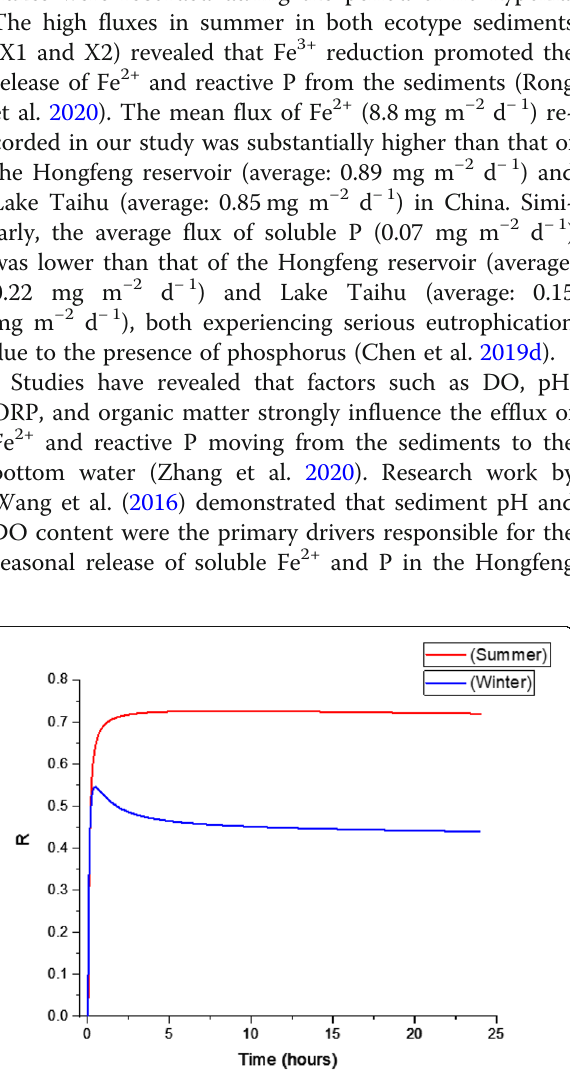
Fig. 6 Time-dependence (DIFS model) of the measured R values for phosphorus in Tianbao reservoir for summer and